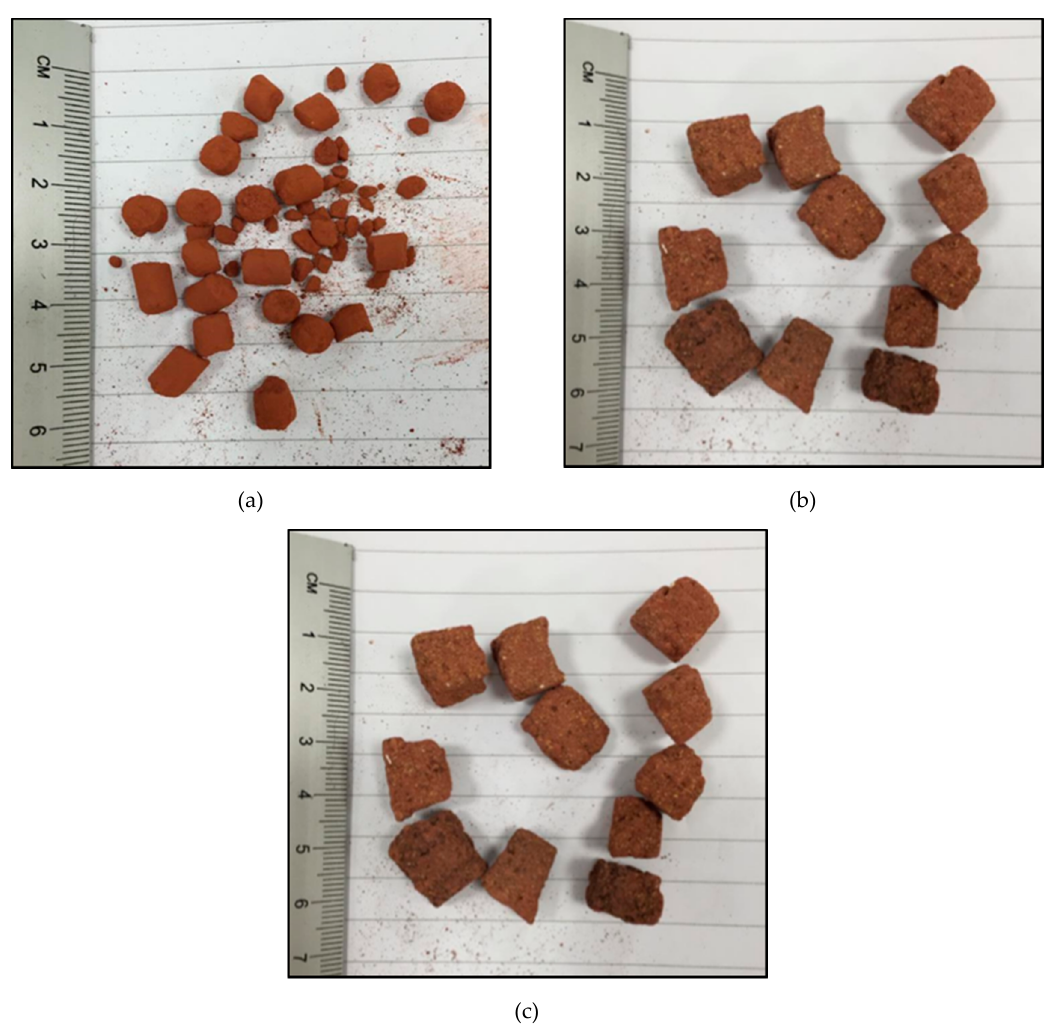
Figure 1. Red media pellets which have all been pre-treated. ( a ) Compressed pellets [19]. ( b ) Fired pellets [19]. ( c ) Fired acid etched pellets [21] .